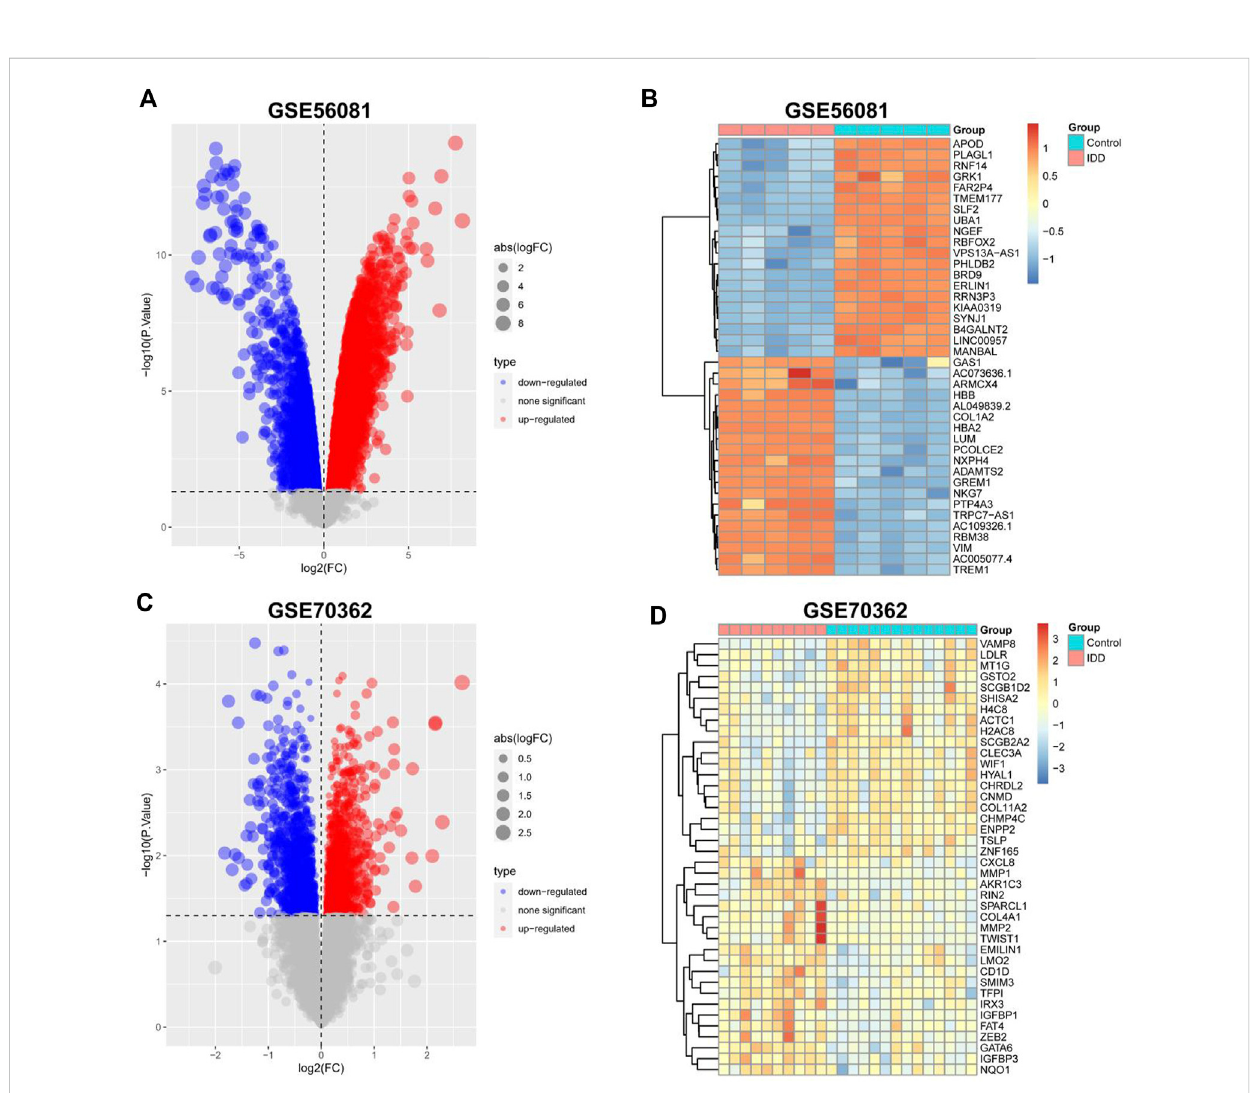
FIGURE 2 Identi fi cation of differentially expressed IDD-related genes. (A,C) Volcano plot of DEGs between intervertebral disc degeneration and normal control group. (B,D) Heatmap of DEGs between intervertebral disc degeneration and normal control group.